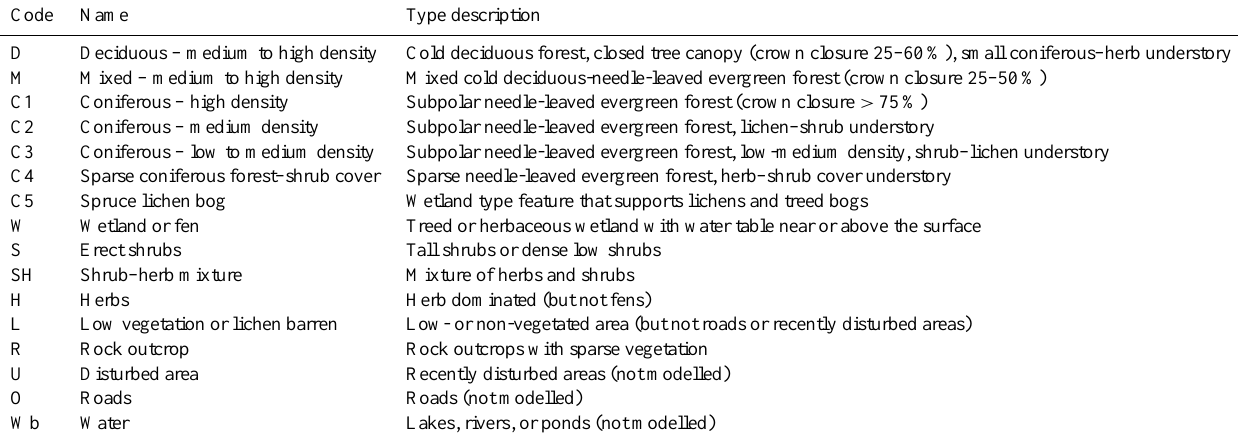
Table 1. Land cover types classified using SPOT.